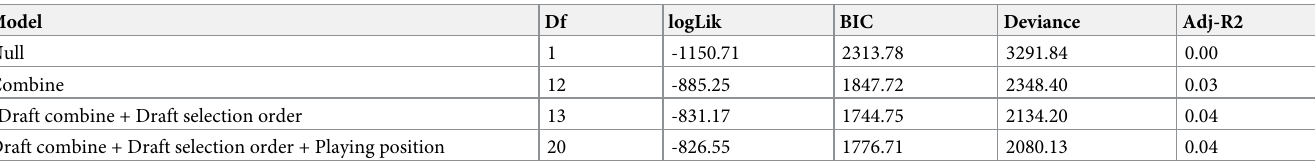
Table 3. Summary of model outputs for AFL Player